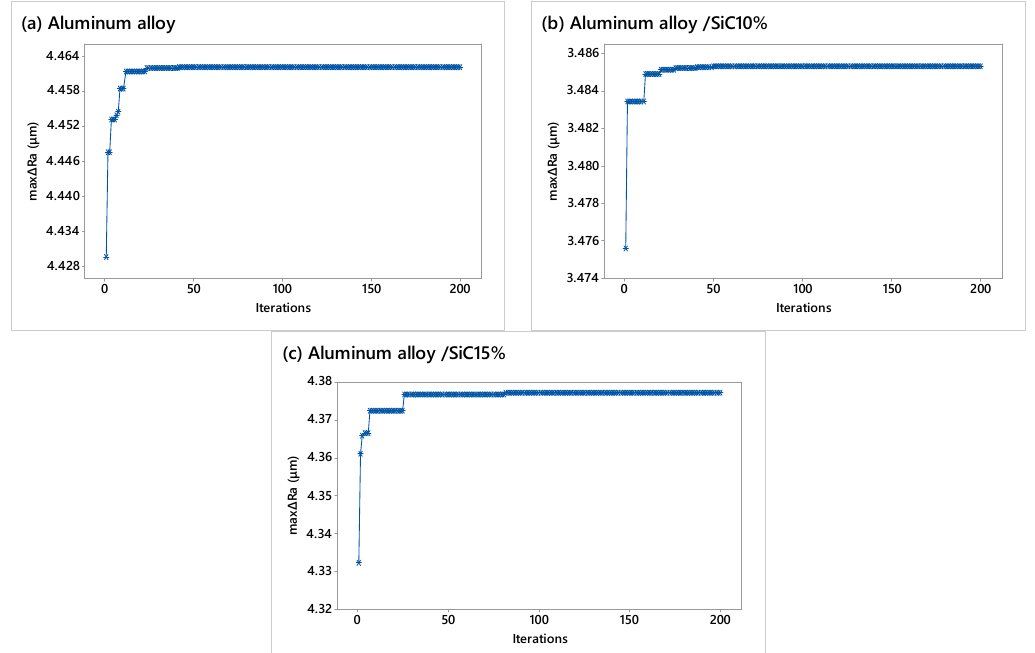
Figure 5. Convergence graphs for optimizing the rotating workpiece abrasive flow nano-finishing process [3] using VEGA for the cases of: ( a ) Aluminum alloy, ( b ) aluminum alloy/SiC10%, and ( c ) aluminum alloy/SiC15%.